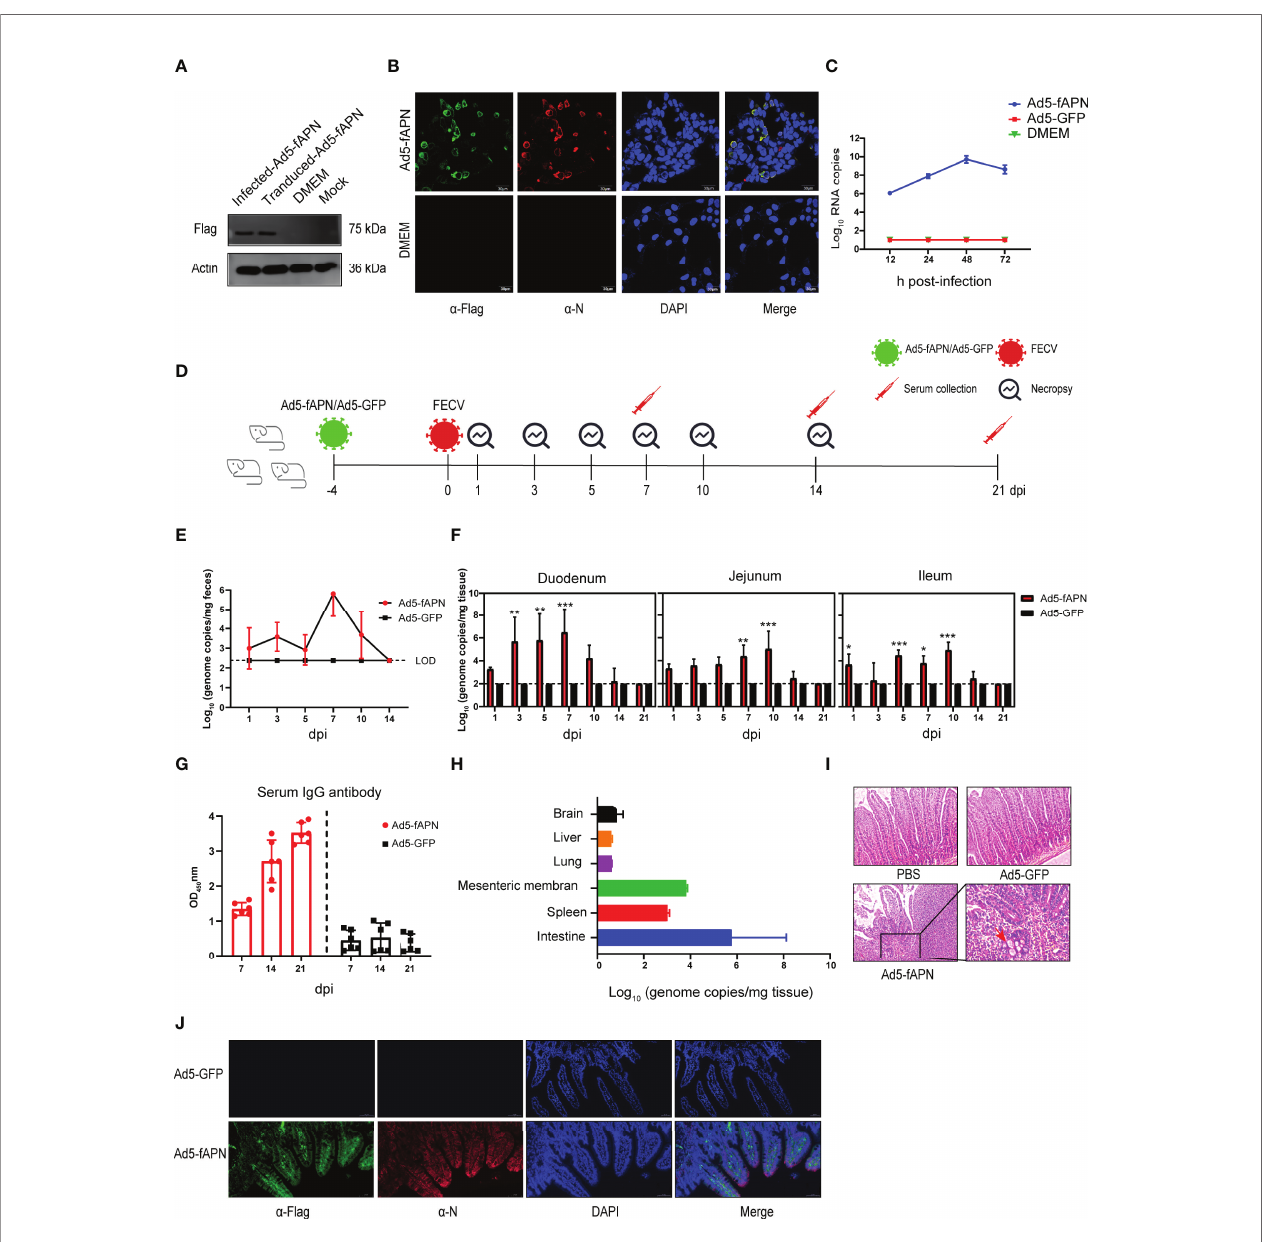
FIGURE 4 | Generation of mice susceptible to FECV infection by transduction with fAPN. (A) Western blot of fAPN expression on Ad5-fAPN-transduced 293 cells. (B) Confocal image of FECV infection after Ad5-fAPN transduction. (C) Ad5-fAPN-transduced cells were infected with FECV at an MOI of 0.01 at 12, 24, 48, and 72 h post-transduction, and virus RNA titers were determined by qPCR. (D) Creation of mice susceptible to FECV infection. 2.5 × 10 6 TCID 50 of Ad5-fAPN/Ad5-GFP was injected intraperitoneally (i.p.) in 5-week-old mice, and 4 d later, 10 5 TCID 50 of FECV was i.p. injected. Feces and small intestinal tissue were collected at fi xed time points to monitor FECV replication. (E) Viral RNA in the feces was determined by qPCR; n = 3 mice in each group at 1, 3, 5, 7, 10, and 14 dpi. (F) FECV RNA load in duodenum, jejunum, and ileum were determined at 1, 3, 5, 7, 10, 14, and 21 dpi by qPCR; n = 3 mice per group. (G) Anti-FECV IgG levels were determined by ELISA in sera from infected mice. Error bars in all samples indicate standard deviation, n = 3 mice per group at each time point. (H) FECV RNA load in the brain, liver, lung, mesenteric membrane, and spleen was determined at 5 dpi by qPCR; n = 3 mice per group. (I) Intestines were collected from mice at the indicated time points, fi xed in zinc formalin, and embedded in paraf fi n. Sections were stained with hematoxylin/eosin and examined for microscopic lesions. (J) Double-labeling immuno fl uorescence cell staining analysis in the mouse intestinal tract. fAPN-Flag is labeled in green, FECV N protein is labeled in red, and nuclei are stained with DAPI (blue). * P <.05; ** P <.01; *** P